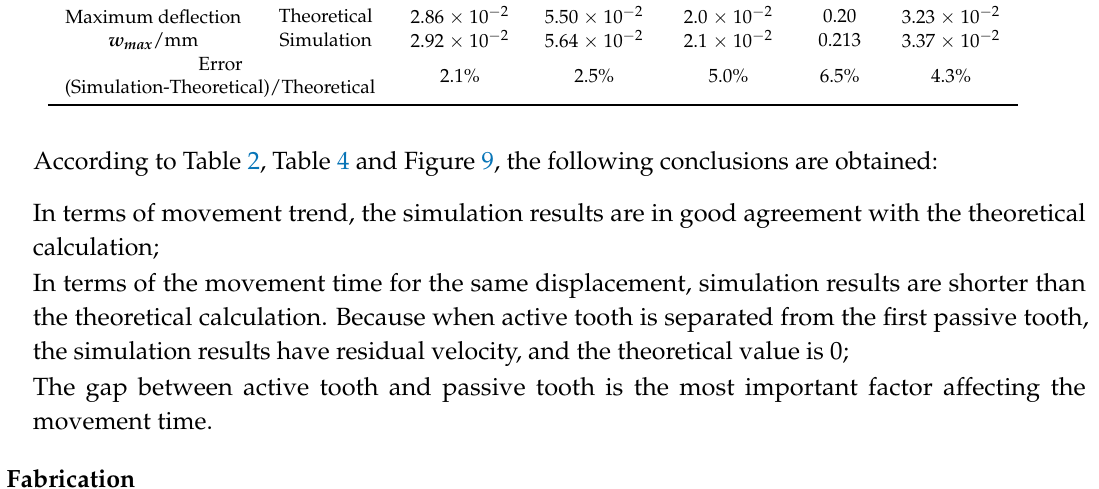
( a ) ( b ) Figure 11. The processing layout ( a ) MEMS S&A system, ( b ) Elastic-beam delaying mechanism. The micro-sample of the elastic-beam delaying mechanism can be obtained based on the digital microscope VHX-6000 series produced by Keyence Corporation, as shown in Figure 12a. And partial view can be obtained based on the Electron microscope, as shown in Figure 12b.